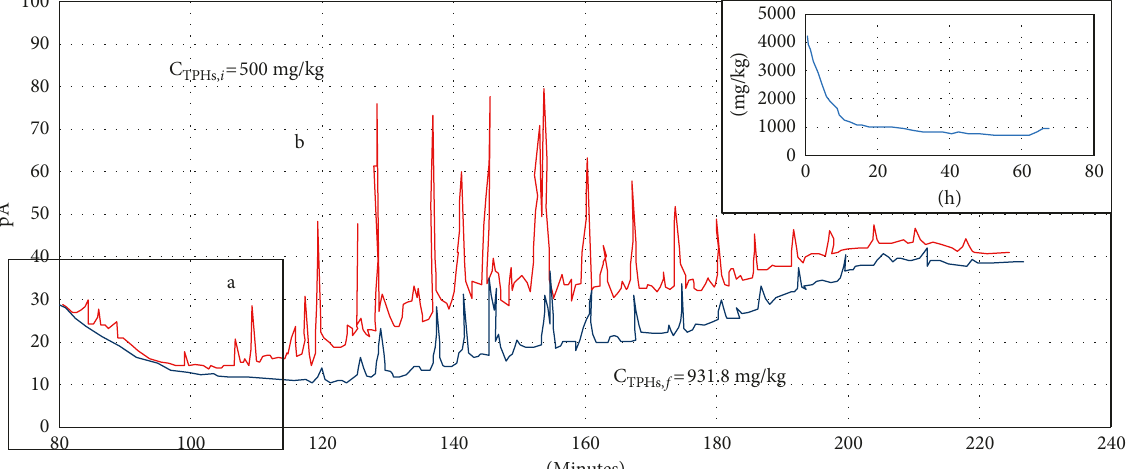
9.32ppm, (b) final (cid:31) 26.80 ppm. (cid:31)